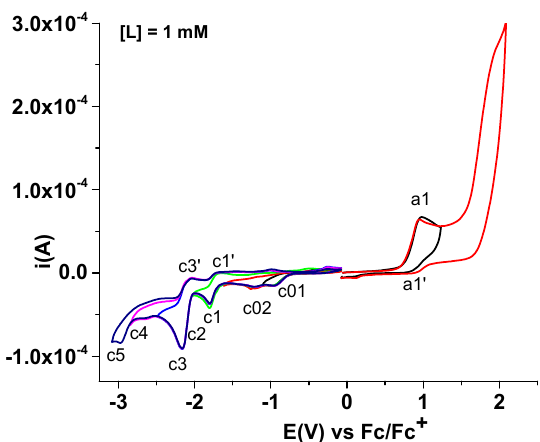
Figure 4. CV curves at different potential ranges for 1 mM solution of L . Table 1. Peak potentials (v) vs. Fc/Fc + and currents from DPV and CV ([ L ] = 1 mM) 1 .